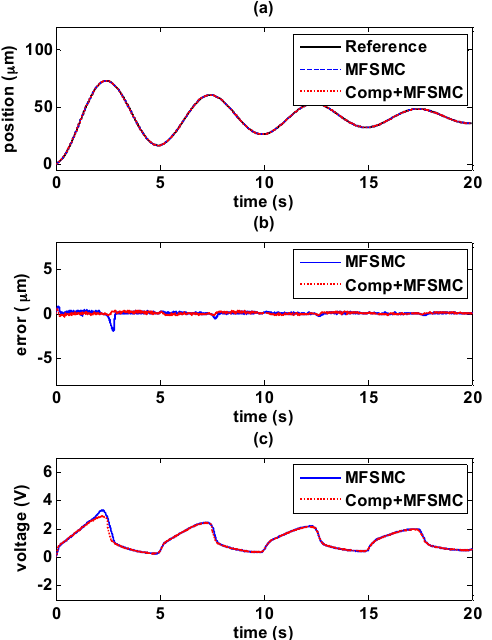
Figure 18. Tracking control comparisons of decaying sinusoidal trajectories with 0.2 Hz frequency between using MFSMC path controller solely and MFSMC path controller with the hysteresis compensator: ( a ) path tracking responses; ( b ) control errors; ( c ) control signals.